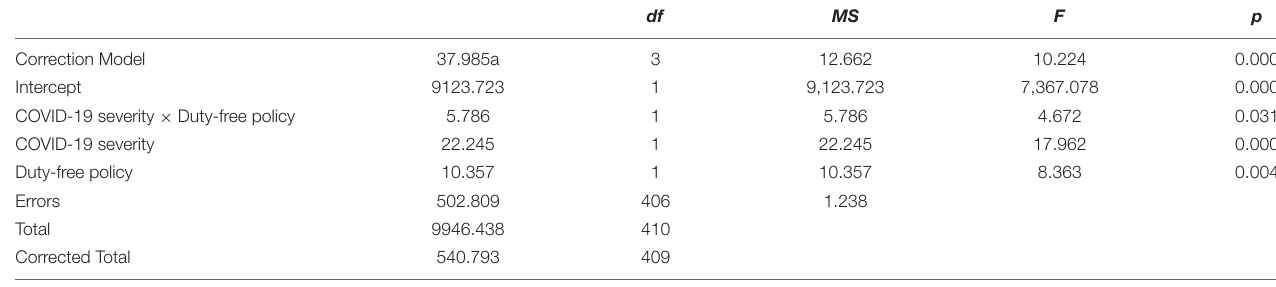
TABLE 6 | Analysis of COVID-19 moderating effect.